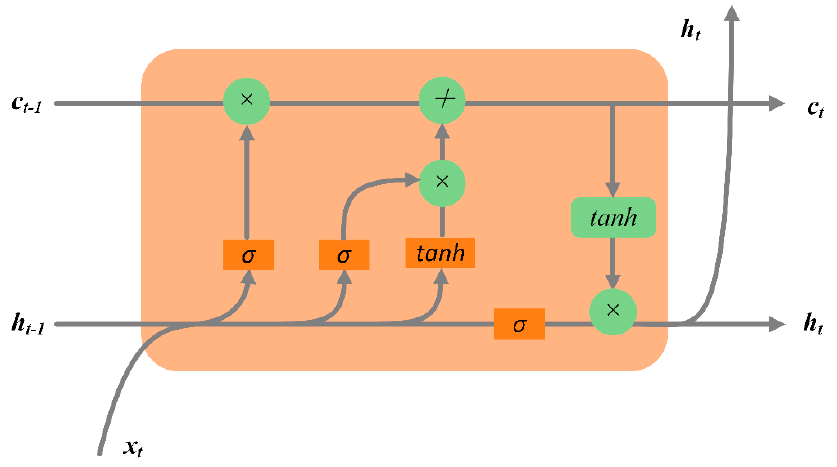
Figure 7. Long short-term memory (LSTM) neural network.